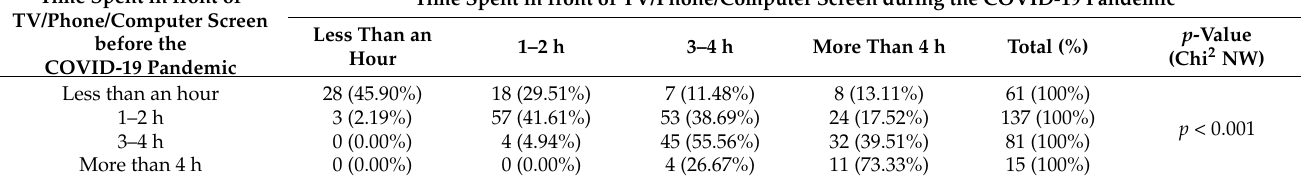
Table 6. Length of time spent in front of a TV/phone/computer screen before and during the COVID-19